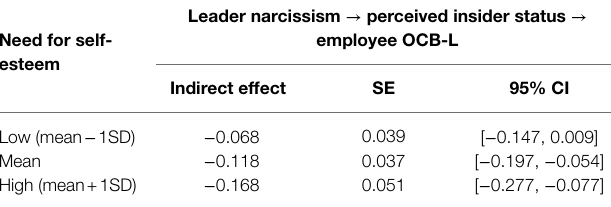
TABLE 4 | Results of the moderated